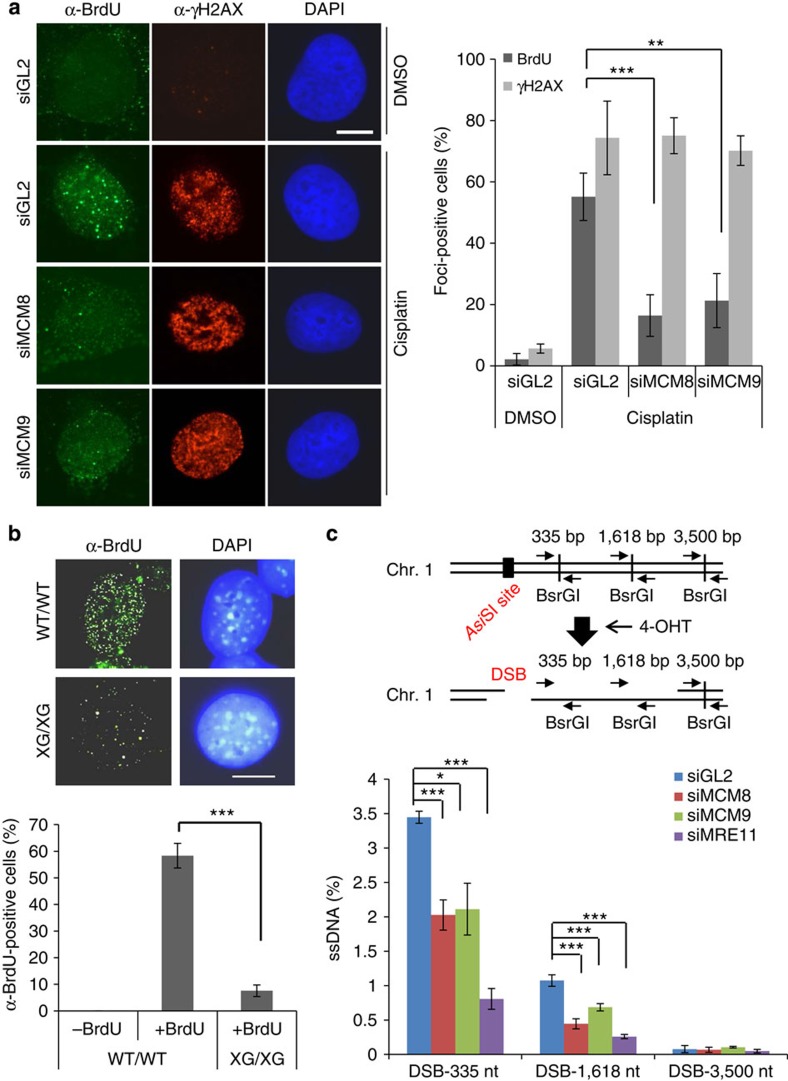
ssDNA generation at DSB depends on MCM8 or MCM9.(a) ssDNA foci measured by BrdU staining without DNA denaturation and γH2AX immunofluorescence foci. Representative images on left and quantification of foci-positive cells on the right. Scale bar, 10 μm. ***P<0.005, **P<0.01; Student's t-test. (b) ssDNA foci (BrdU foci) in MEFs with WT MCM9 (WT/WT) or with homozygous mutation for MCM9 (XG/XG) after exposure to cisplatin. Bottom: mean±s.d. of triplicates. Scale bar, 10 μm. ***P<0.005; Student's t-test. (c) Quantitative measurement of DNA resection 4 h after addition of 4-OHT to ER-AsiSI U2OS cells. Percentage of ssDNA at indicated sites was measured by qPCR using the primer pairs indicated on the cartoon after digestion with BsrGI. Bottom: % of ssDNA at different sites. ***P<0.005, *P<0.05; Student's t-test. All error bars represent s.d. of the mean from triplicates.